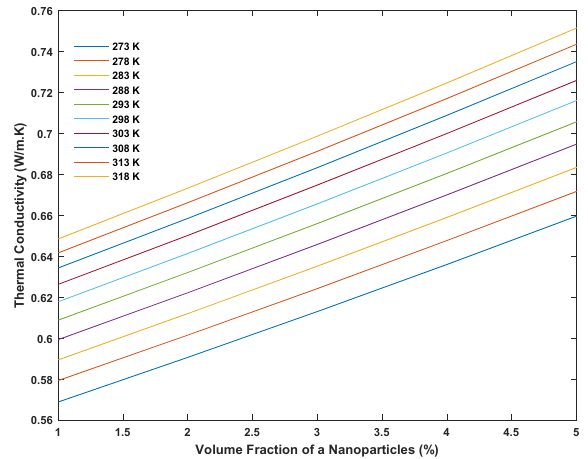
Fig. 4. Effect of volume fraction of nanoparticles on thermal conductivity of nanofluids